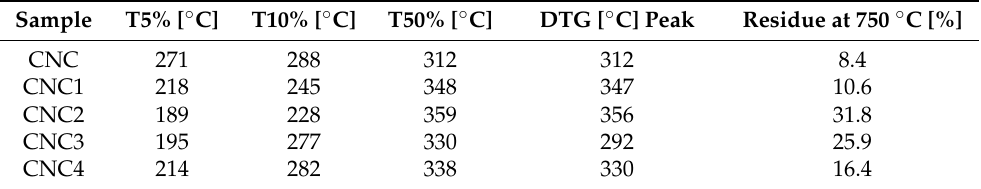
Table 3. Thermogravimetric data.